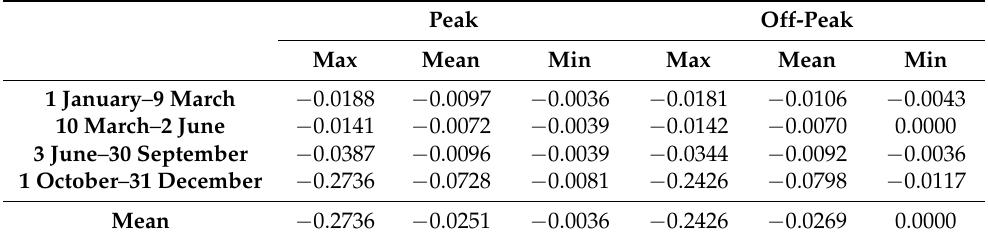
Table 8. Summary Statistics of the Hourly Elasticity Estimates, Peak and Off-peak Hours, aggregated by different periods of the year. Peak Off-Peak Max